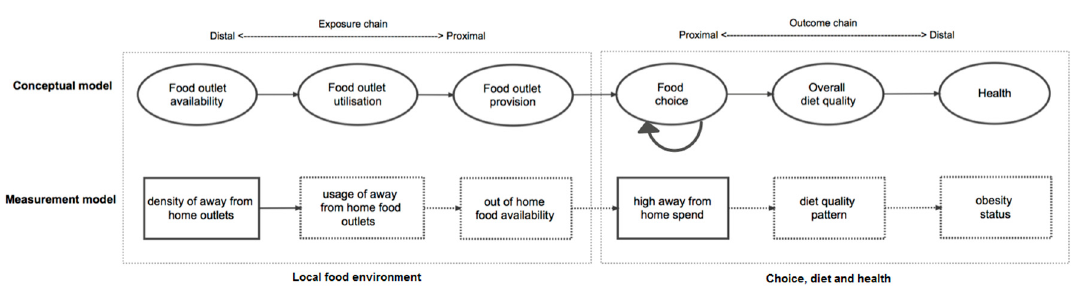
Figure 1. Conceptual model describing how the local food environment might relate to diet and health, highlighting measurement model for study hypothesis.